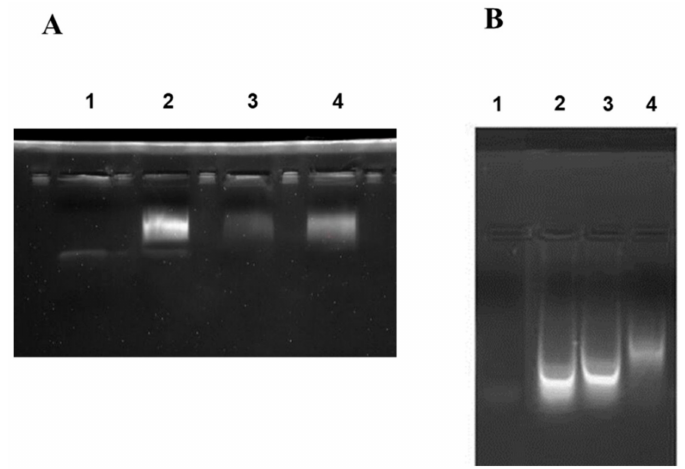
Figure 3. Electrophoresis mobility shift assay (EMSA) performed on Ada-AlkA ( A ) and Ogt ( B ) proteins. A biotin-labeled DNA probe was incubated with each individual protein for 20 min at 25 ◦ C. Panel A: Lane 1, DNA probe. Lane 2, 3 and 4 DNA-probe incubated with di ff erent amounts of Ada-AlkA (40, 20 and 60 µ M, respectively). Panel B: Lane 1 DNA probe. Lanes 2, 3 and 4 DNA-probe incubated with di ff erent amounts of Ogt (10, 50 and 80 µ M,